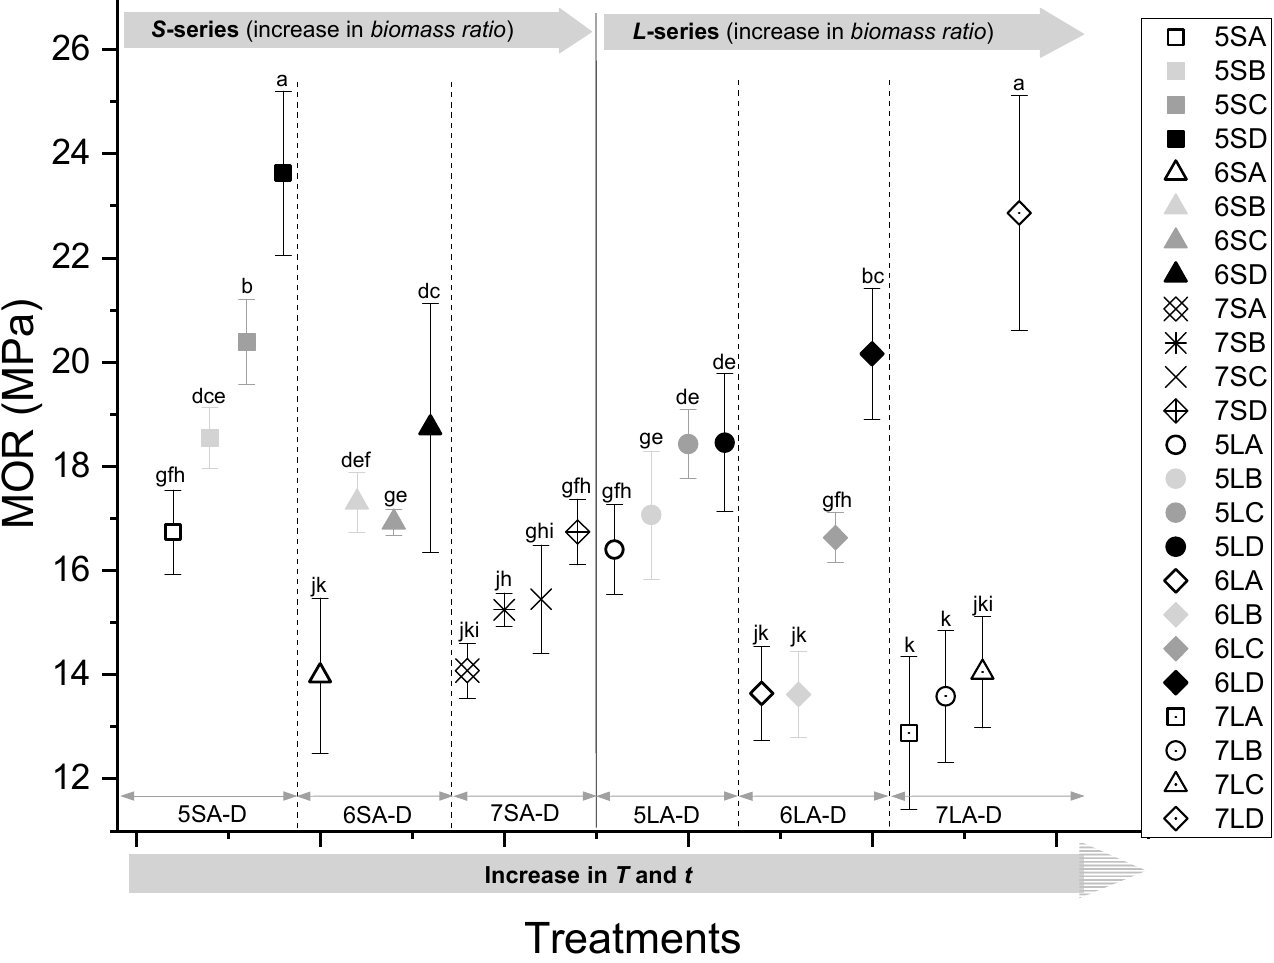
Figure 10. Flexural strength (MOR) of the WPCs pressed at different temperatures and times (A–D) with 50, 60, and 70% biomass at two particle sizes (S and L). Symbols with the same letters are not significantly